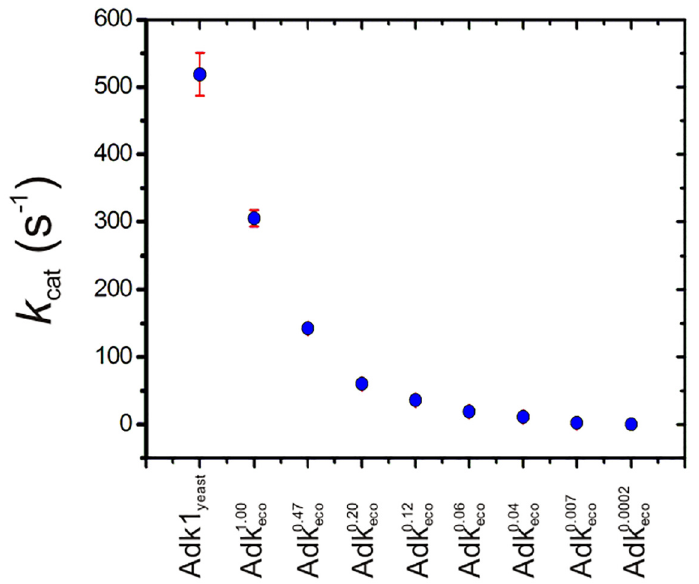
Fig 3. Catalytic activity of Adk variants at 20°C. Adk variants analyzed were designed to have a broad coverage of k cat which is illustrated by a display of k cat from Table 1 vs the corresponding Adk